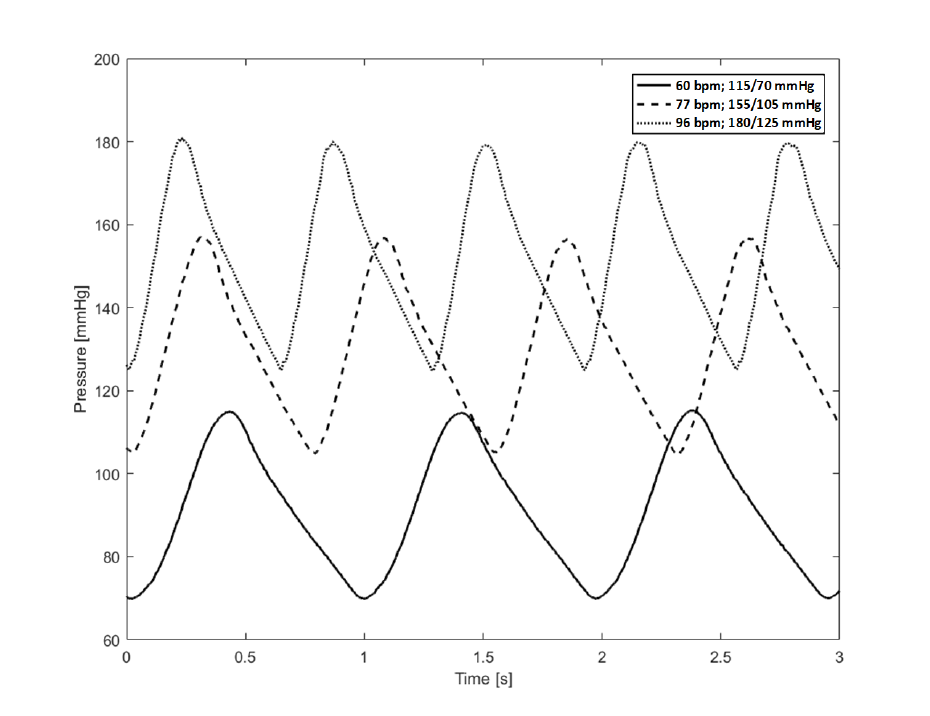
Figure 2. Pulse waves measured via an extravascular sensor for various heart rates and consequent blood pressures. It is showns the general shape of the pulse wave remains similar regardless of heart rate and Blood Pressure (BP).